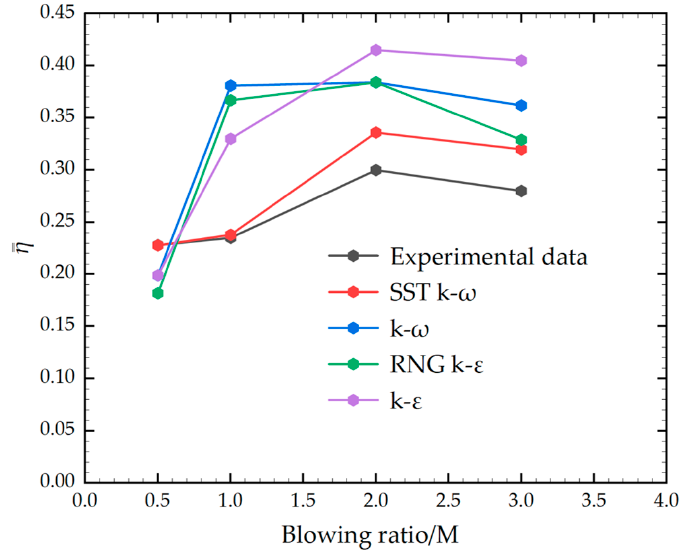
Figure 2. The area averaged cooling effectiveness of the leading edge region under different film hole-blowing ratios.